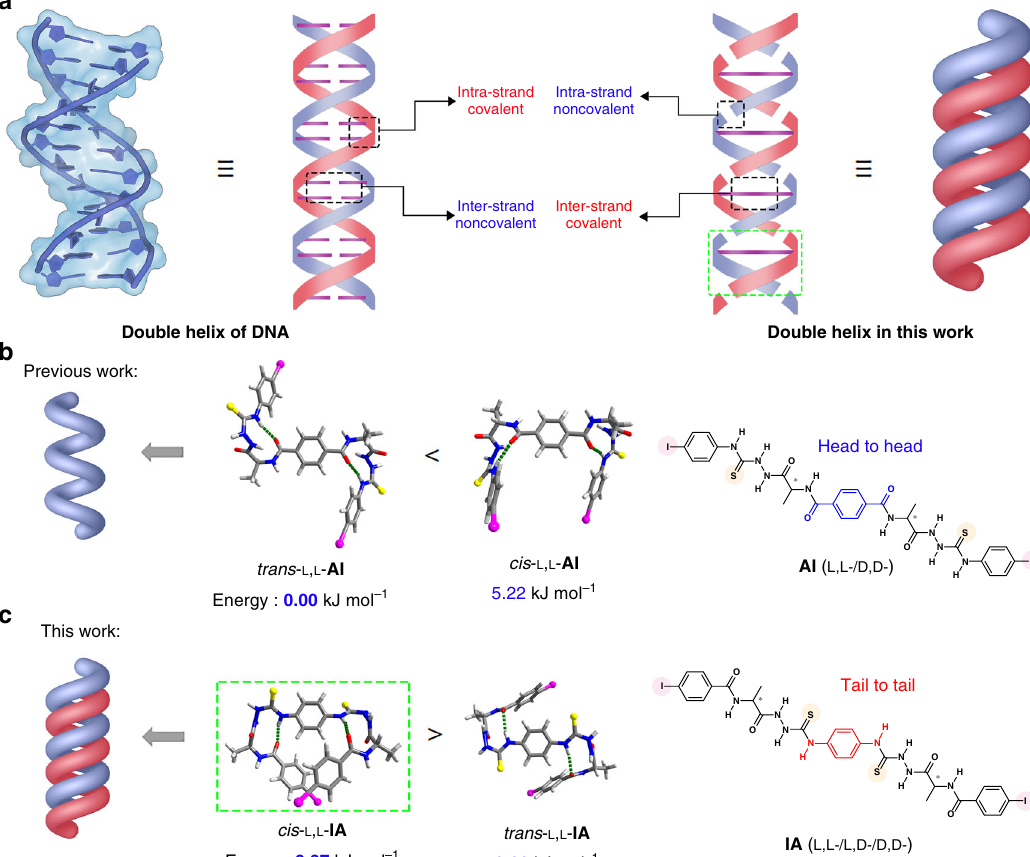
Fig. 1 Schematic illustration of double helix and molecular design. a Schematic diagram of the double helix of DNA and that built in this work, featuring intra-strand noncovalent and inter-strand covalent interactions in the latter. b DFT-optimized structures and corresponding energies of trans -L,L- AI and cis - L,L- AI in gas phase and molecular structures of AI . The single-stranded supramolecular helix is formed from trans -L,L- AI 22 . c DFT-optimized structures and corresponding energies of trans -L,L- IA and cis -L,L- IA in gas phase and molecular structures of IA in this work. The supramolecular double helix is formed from cis -L,L- IA . The asterisks in the structures indicate the chiral carbons. Dashed green lines highlight intramolecular hydrogen bonds (IHBs) that represent β -turn structures. Method: DFT B3LYP with the 6 – 311 G** basis set for C, H, O, N, and S atoms, and LANL2DZ for I